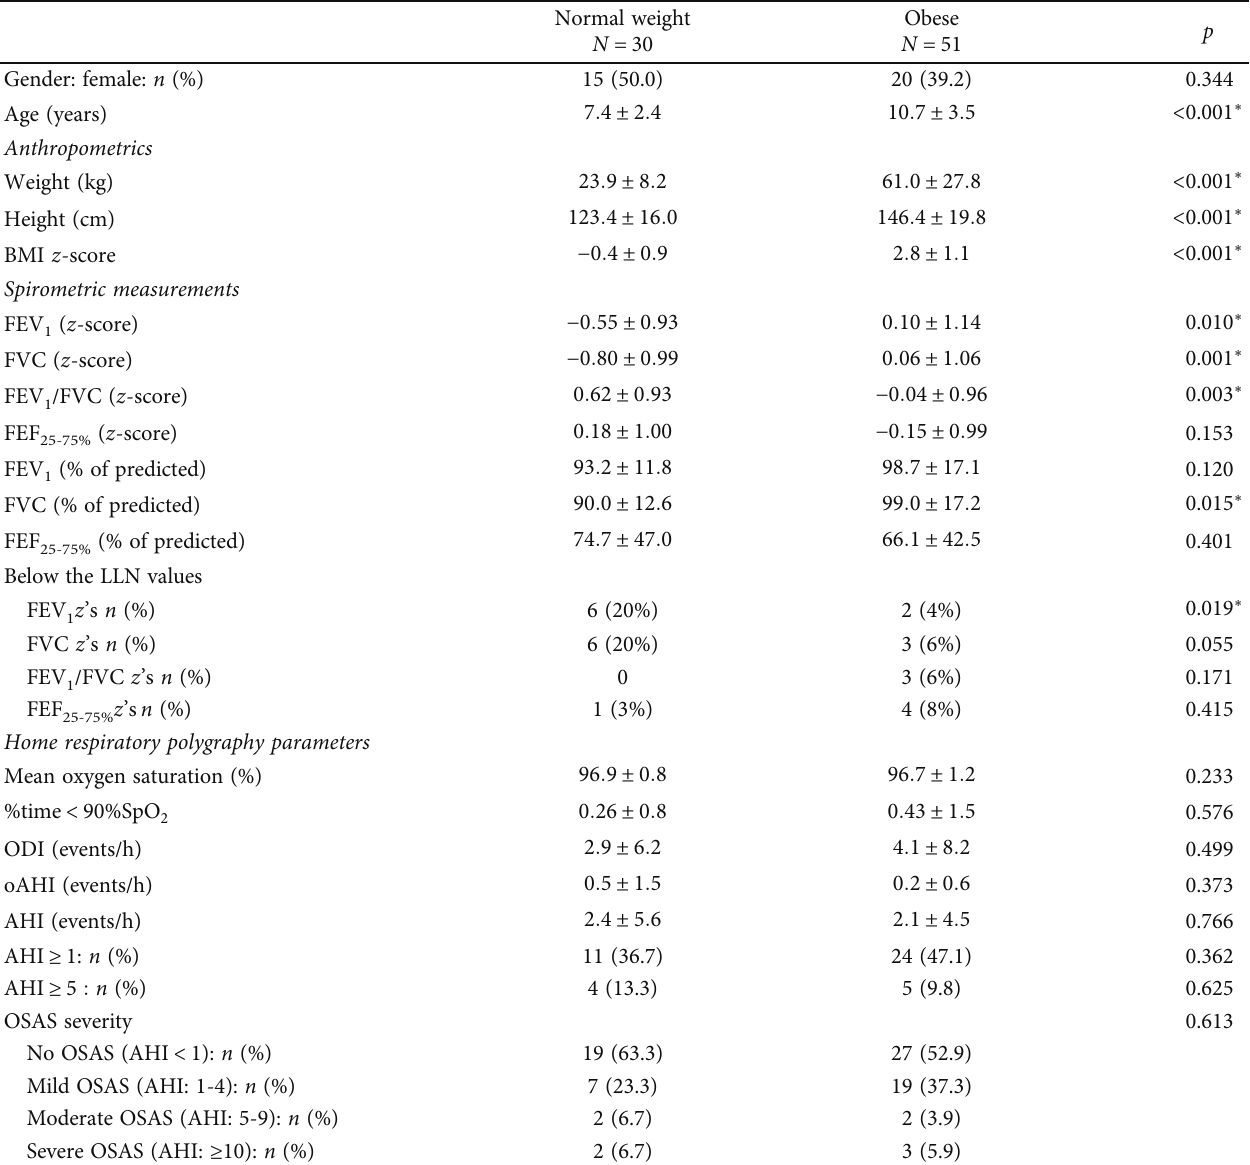
Table 1: Characteristics of